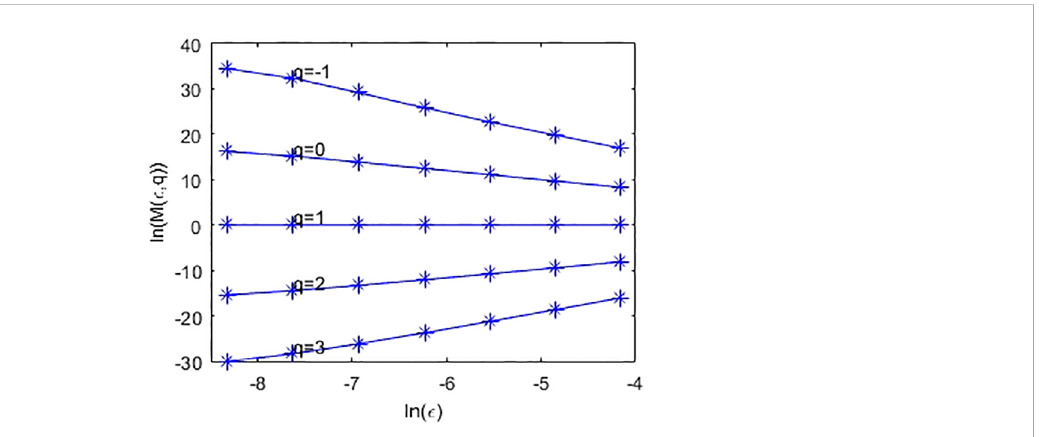
FIGURE 2 Linear fi t of ln(M( ϵ , q )) and ln( ϵ ), where ϵ is set to 2 -6 ,2 -7 ,2 -8 ,2 -10 ,2 -11 ,2 -12 , and 2 -13 ,